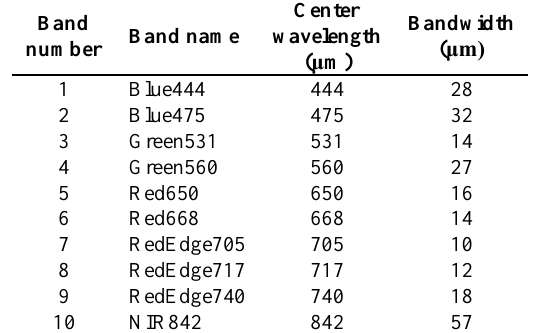
Spectral characteristics of the ten bands acquired by the MicaSense Dual-Camera